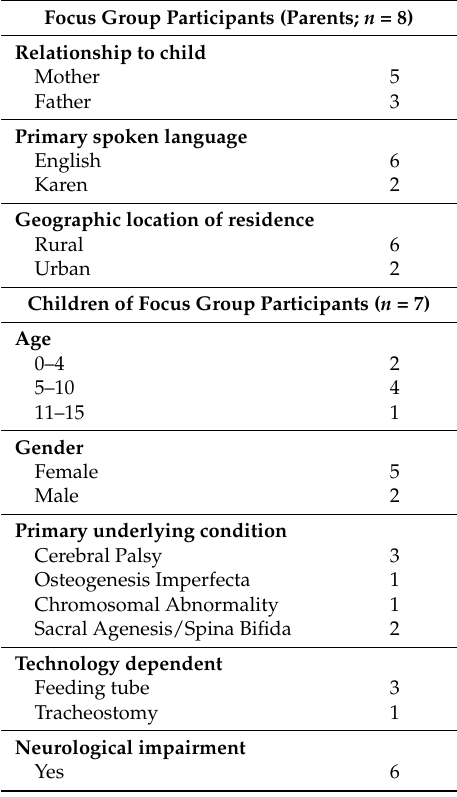
Table 2. Demographics of focus group participants ( n = 8) and their children ( n =